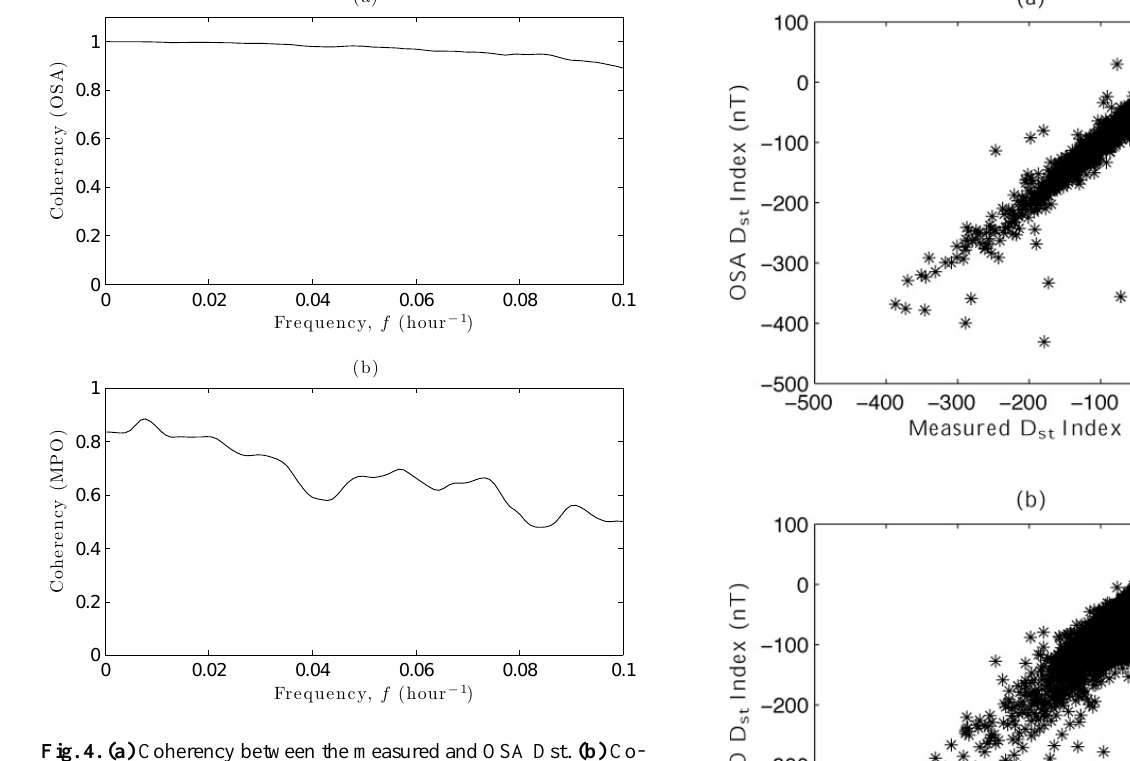
Fig. 4. (a) Coherency between the measured and OSA Dst. (b) Co- herency between the measured and MPO Dst.